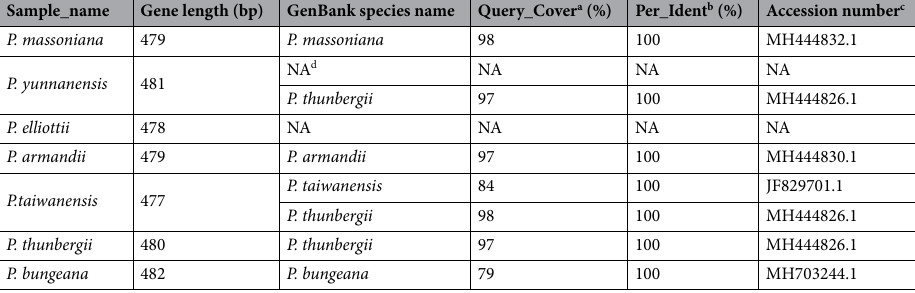
Table 1. ITS2 sequence markers